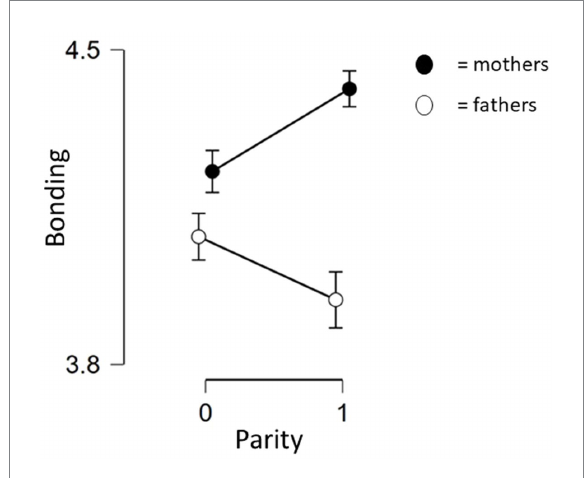
FIGURE 1 Different effect of parity on bonding for mothers and